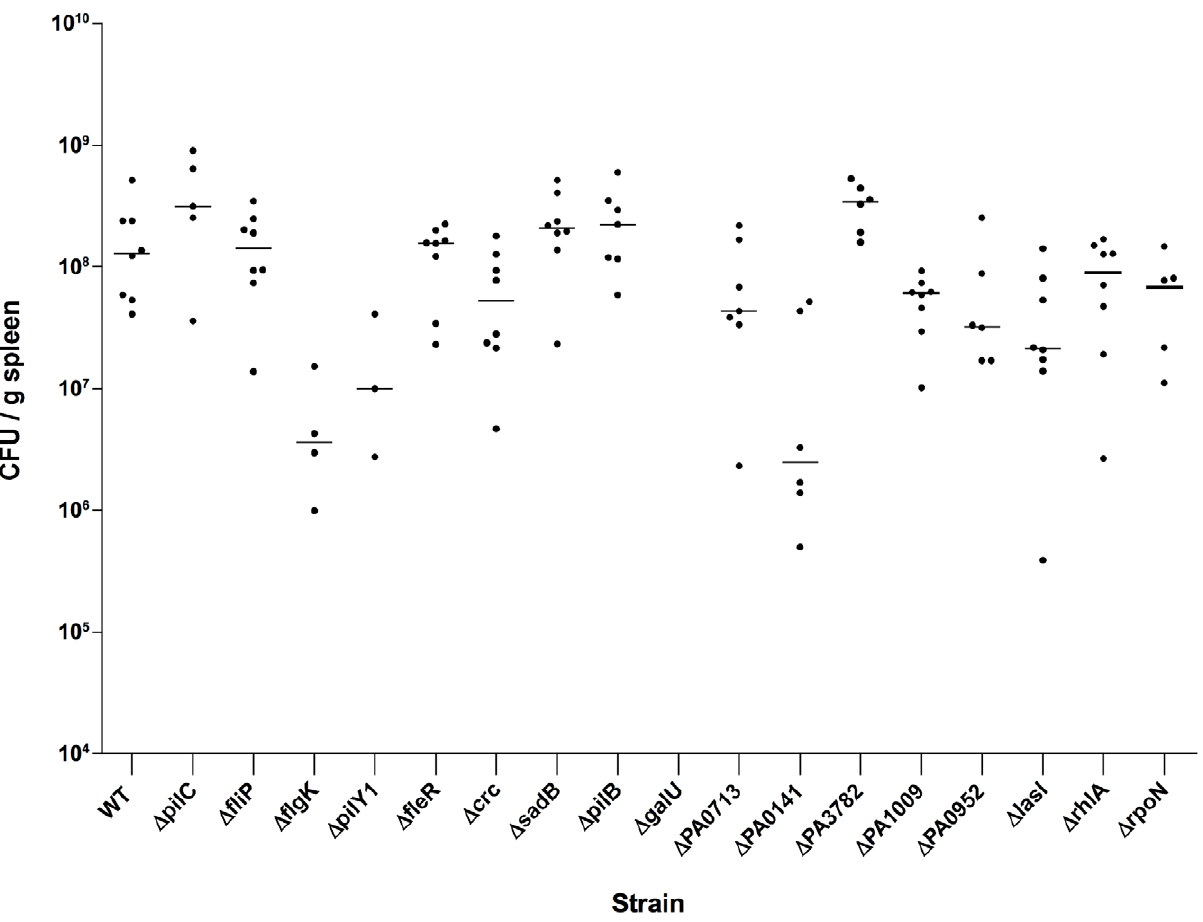
Figure 5. Viable counts of P.aeruginosa strains PA14 and PA14 Tn-mutants recovered from murine spleens. Points represent result from individual animals (female 6–8 wk-old C3H/HeN mice), and horizontal lines represent the medians. n=6–8 for each strain (please refer to Table 3 for actual numbers for each mutant strain). Mice were initially colonized with PA14 and then subsequently made neutropenic with monoclonal antibody RB6-8C5 (0.200 mg IP once). Tn, transposon-insertion.